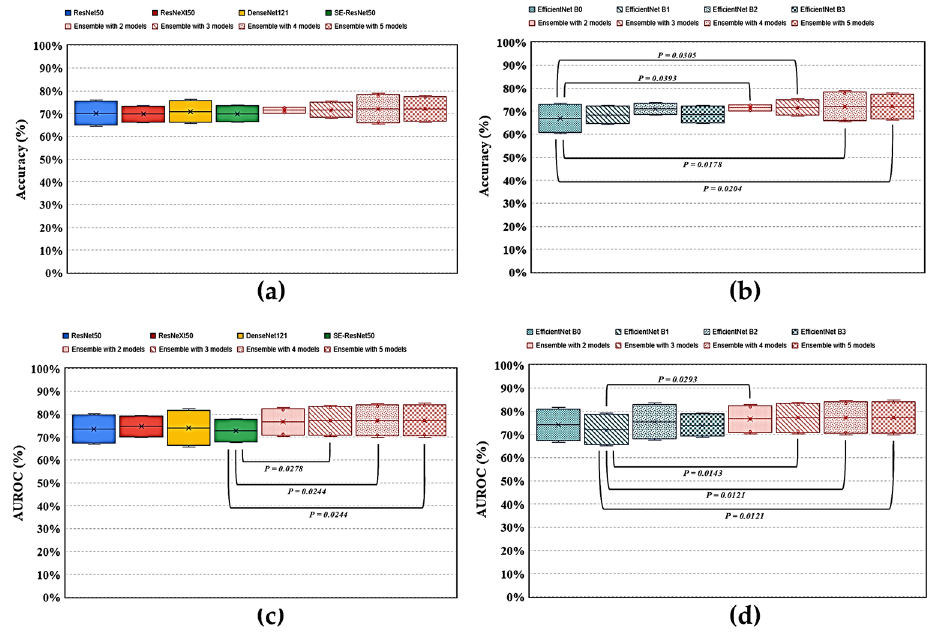
Figure 6. Comparison of the performance of ensemble models with constituent deep learning models via an external eye photo for differentiating Pseudomonas from non- Pseudomonas keratitis. ( a , b ) Diagnostic accuracy of different models; ( c , d ) area under the receiver operating characteristic curve (AUROC) of the models. p < 0.05 was recognized as a statistical difference.